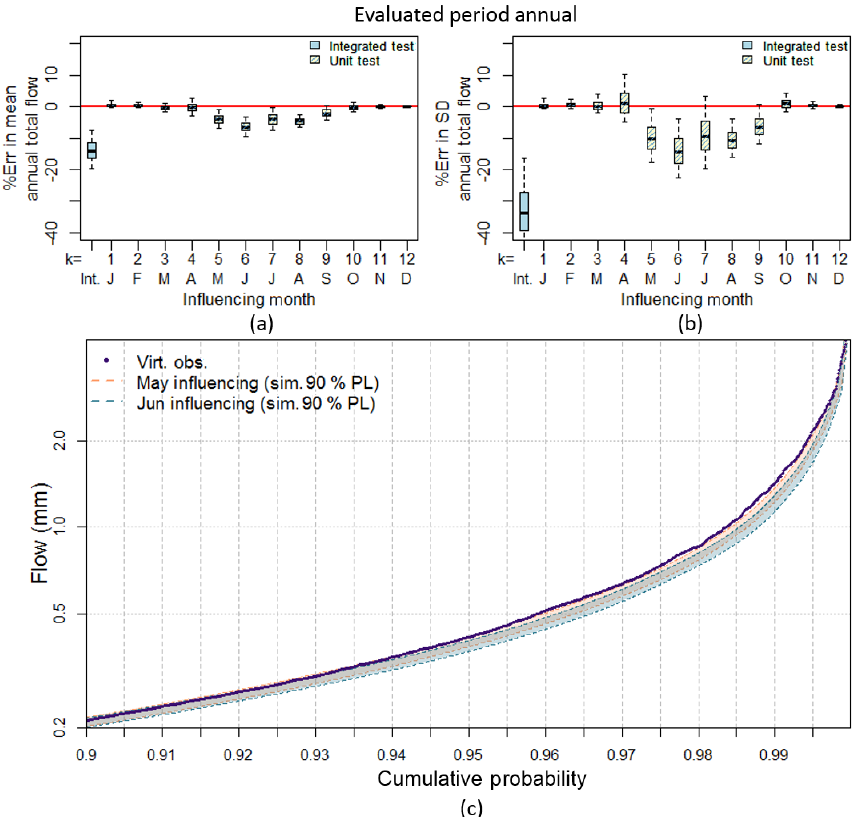
Figure 13. Happy Valley, Site 10 (a) unit test error in mean annual total flow, and (b) unit test error in standard deviation of annual total flow, and (c) annual flow duration curve when May and June are selected as influencing months in unit test (top 10% of flow days shown). Boxplot whiskers indicate the 90% limits of the simulated streamflow